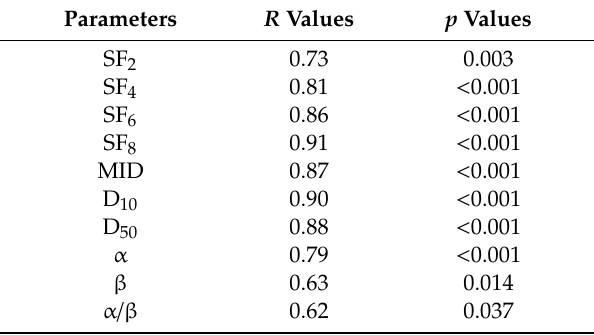
Table 2. Correlation of clonogenic survival parameters between datasets A and